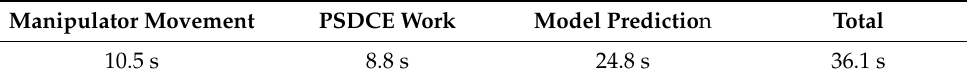
Table 6. Time for each step of the system. Each step runs in tandem. Manipulator